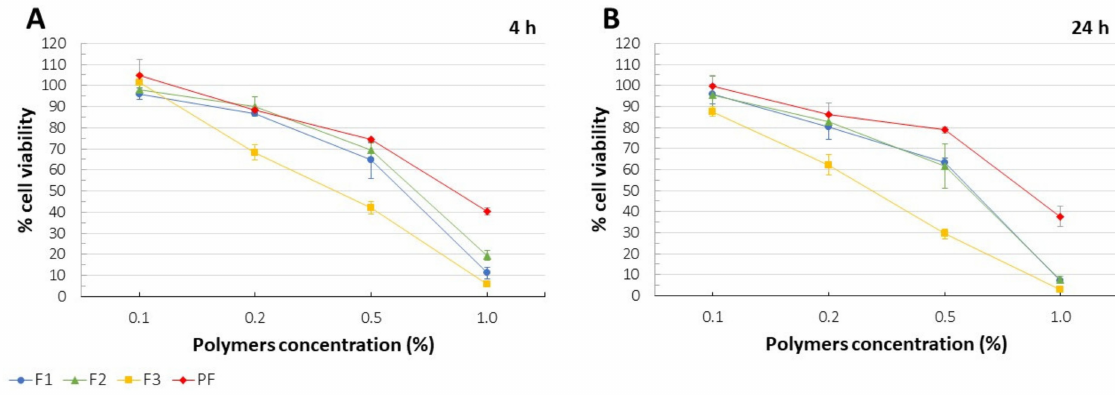
Figure 7. % cell viability determined in MTT assay after 4 h ( A ) and 24 h ( B ) for F1–F3 and placebo films (PF) at different polymers concentrations (mean ± SD, n = 4, p < 0.05).